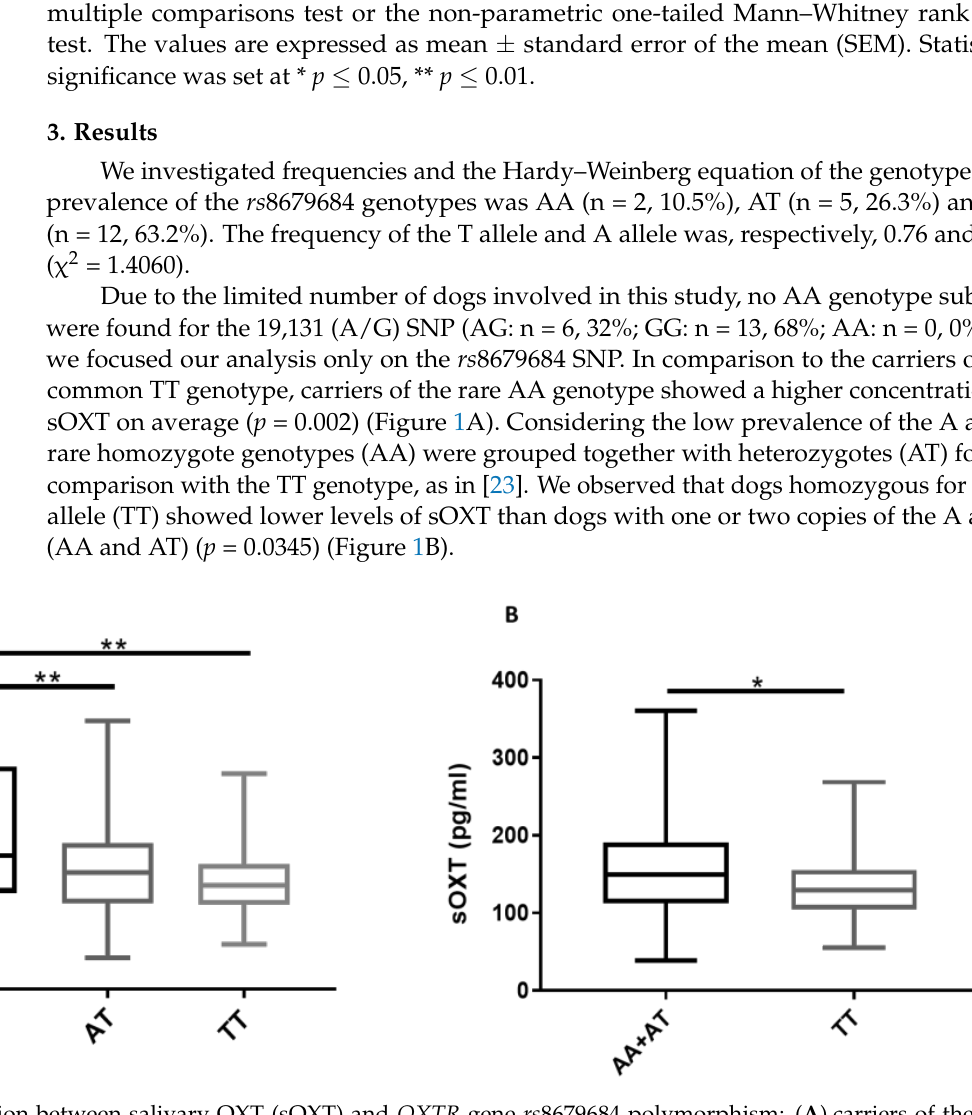
Figure 1. The correlation between salivary OXT (sOXT) and OXTR gene rs 8679684 polymorphism: ( A ) carriers of the AA genotype (n = 2) showed higher levels of sOXT compared to carriers of the AT (n = 5) and TT (n = 12) genotype (** p ≤ 0.01—Tukey’s multiple comparisons test). ( B ) The presence of the A allele in SNP rs 8679684 was associated with higher level of sOXT (* p ≤ 0.05—Mann–Whitney test).